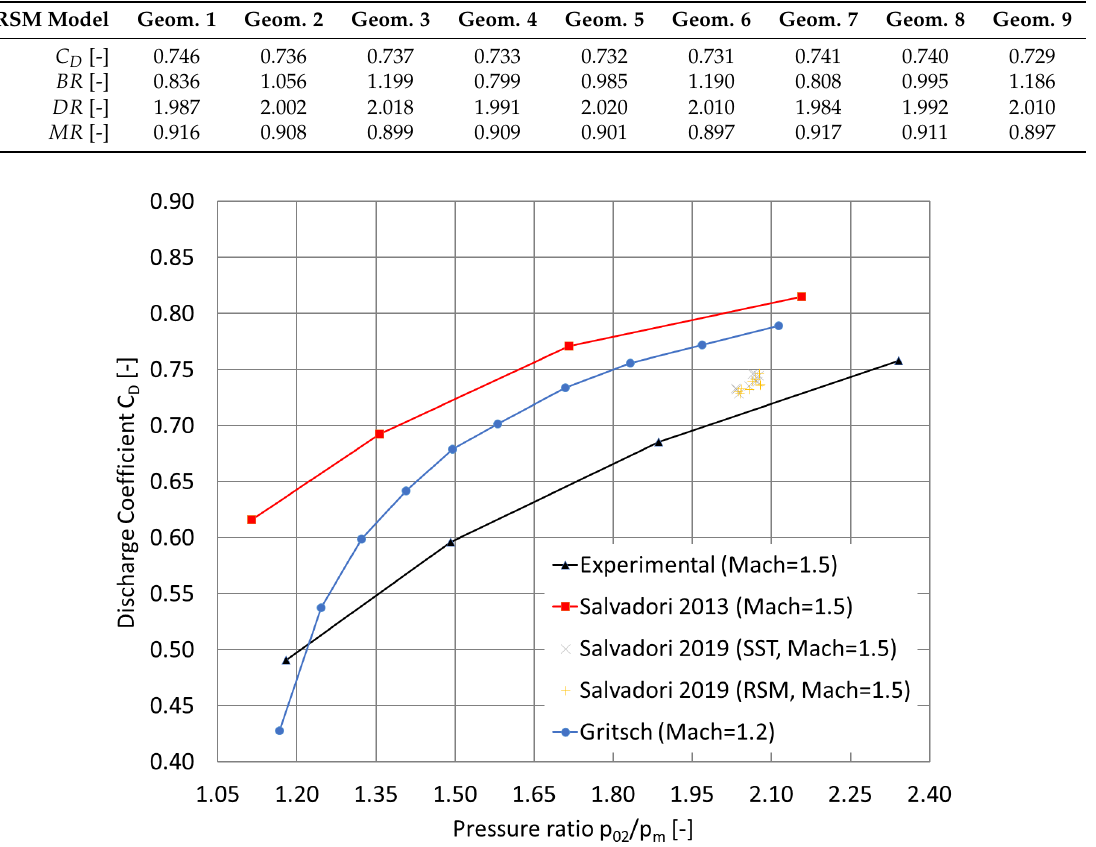
Figure 5. C D values obtained using the SST model and RSM